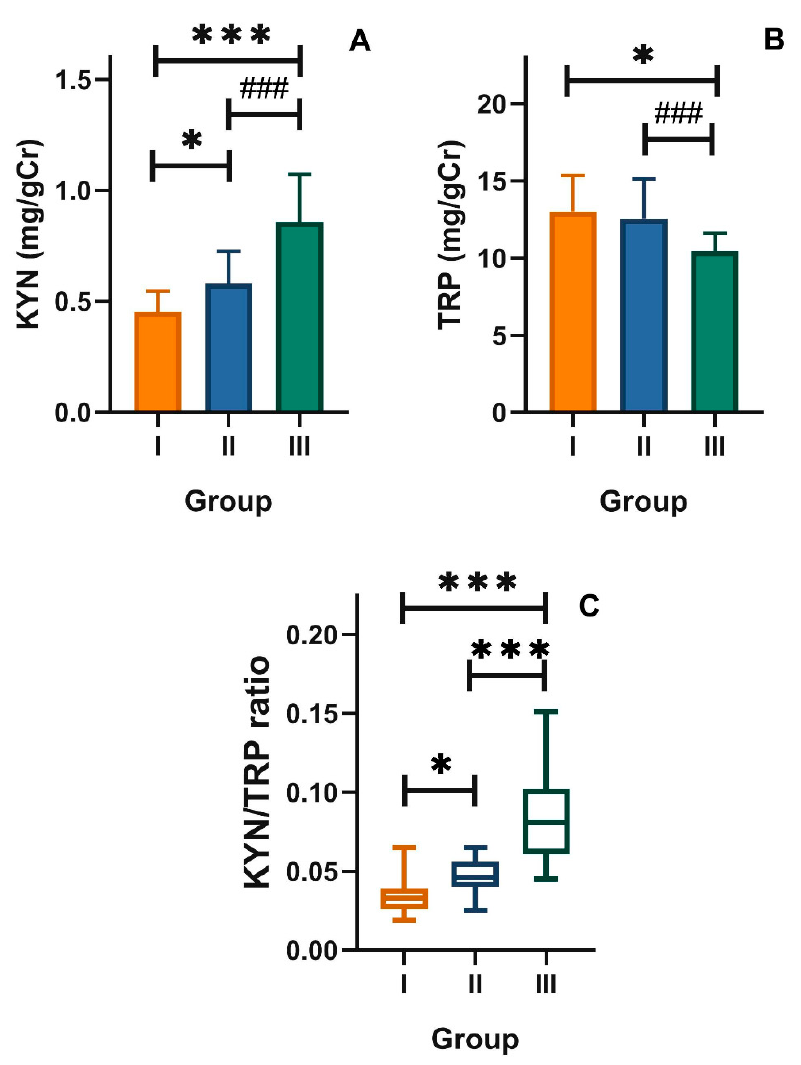
Figure 2. Urinary levels of ( A ) L-kynurenine (KYN) and ( B ) tryptophan (TRP) expressed in milligram per gram of creatinine (mg/gCr), and ( C ) kynurenine/tryptophan ratio (KYN/TRP) in healthy young adult individuals (group I) and in the elderly without (group II) and with mood disorders (group III); mean ± SD ( A , B ) or median with boxes represent I and III quartiles, and error bars represent 1.5 times the interquartile distance. Differences between groups were analyzed by ANOVA ( A , B ) with Dunnett’s multiple comparison method (group III vs. I and group II vs. I) or contrast (group III vs. II); the differences between groups in C were assessed by Kruskal–Wallis test; n = 30 in each group; * p < 0.05, *** p < 0.001; ### p < 0.001.